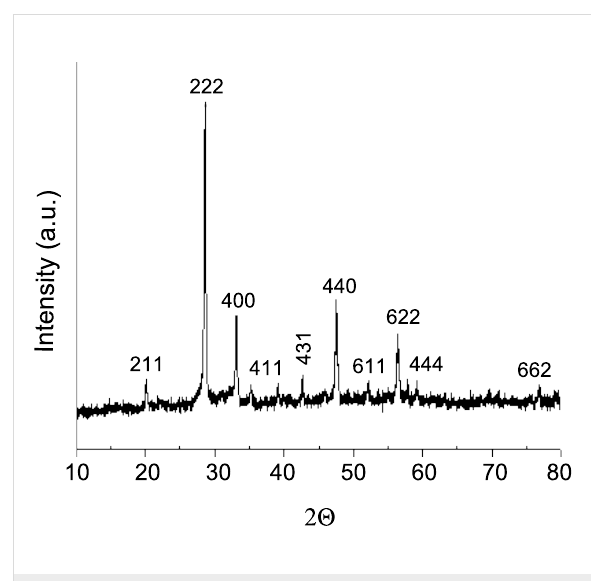
Figure 3: XRD measurements of biosynthesized Gd 2 O 3 nanoparticles.